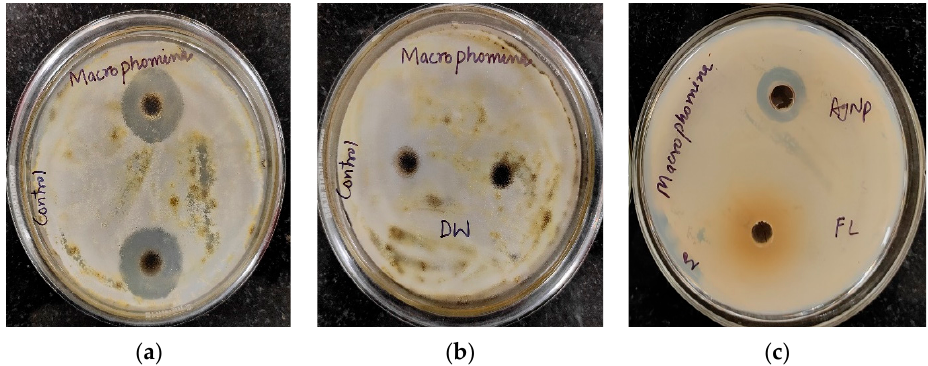
Figure 10. Antifungal activity against Macrophomina phaseolina : ( a ) positive control (Nystatin); ( b ) negative control (distilled water (DW)); ( c ) AgNPs and leaf extract (FL).